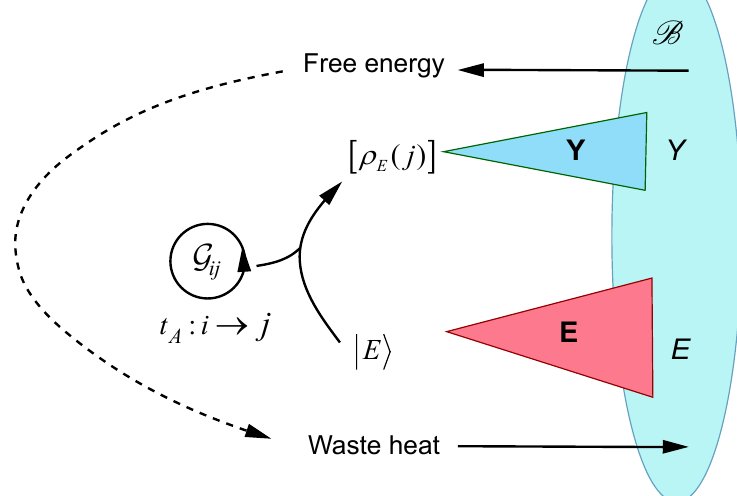
Figure 5: Cartoon illustration of quantum reference frames (QRFs) required to observe and write a readable memory of an environmental state | E ⟩ . The QRFs E and Y read the state from E and write it to the memory Y respectively. Any identified system S must be part of E. The clock G ij is a time QRF that defines the time coordinate t A . The dashed arrow indicates the observer’s thermodynamic process that converts free energy obtained from the unobserved sector F of B to waste heat exhausted through